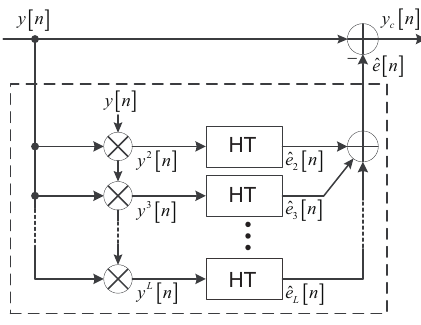
Figure 4. Calibration structure for nonlinear mismatches in M -TIADCs. The HT block is the same as Figure 3b, where the parameters c k , l are replaced by the estimated parameters ˆ c k , l [ n ]